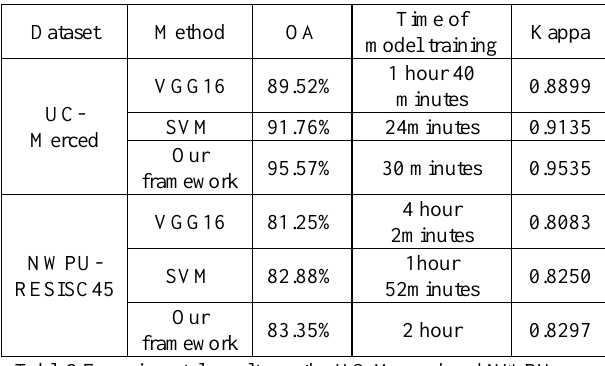
Table2 Experimental results on the UC-Merced and NWPU- RESISC45 dataset